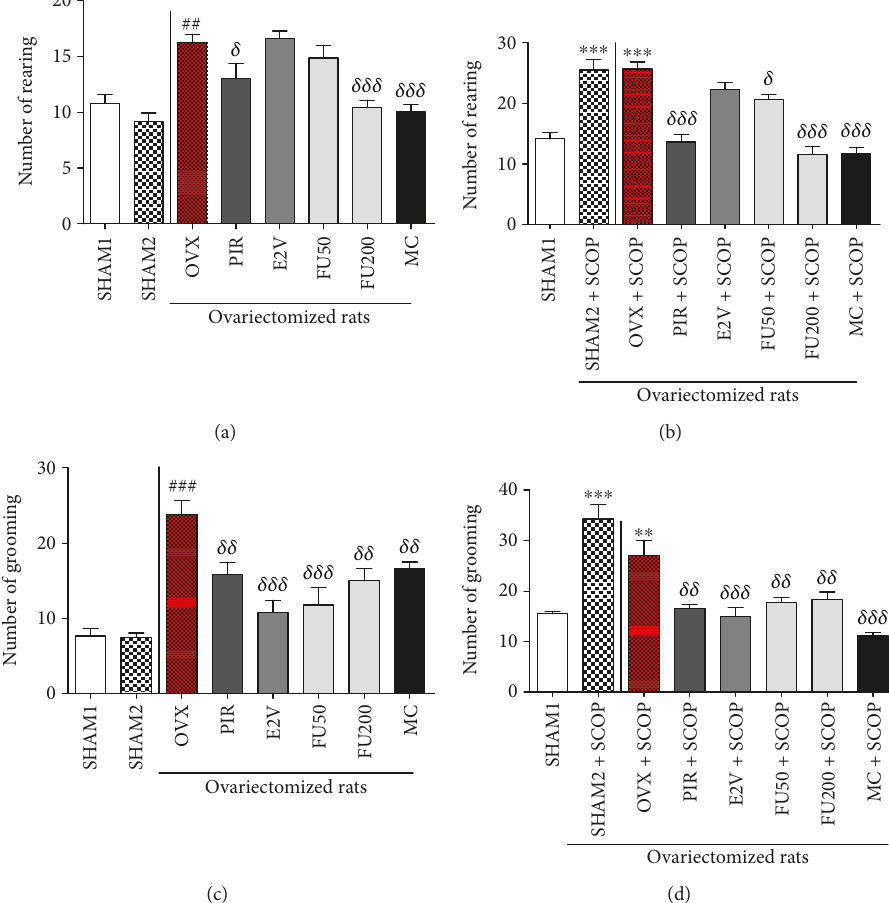
Figure 6: Graphic representation of the number of rearing (a and b) and grooming (c and d) of rats in the Y-maze before and after scopolamine exposition in ratstreated with di ff erentsubstances intothe Y-maze. SHAM 1=sham-operated rats treated with vehicle as normal control 1; SHAM 2=sham-operated rats treated with vehicle as normal control 2; OVX=ovariectomized rats treated with vehicle as negative control; PIR=ovariectomized rats treated with piracetam at the dose of 1.5mg/kg BW as positive control 1; E2V=ovariectomized rats treated with estradiol valerate at the dose of 1mg/kg BW as positive control 2; FU 50 and 200=ovariectomized rats treated with F. umbellata aqueous extract at the doses of 50 and 200mg/kg BW, respectively; MC=ovariectomized rats treated with 7-methoxycoumarin at the dose of 1mg/kg BW. SCOP=animal that received a single dose of scopolamine (2mg/kg BW). ∗∗ p < 0 01 and ∗∗∗ p < 0 001 as compared to the SHAM 1 group; ## p < 0 01 and ### p < 0 001 as compared to the SHAM 2 group; δ p < 0 05 , δδ p < 0 01 , and δδδ p < 0 001 as compared to the OVX